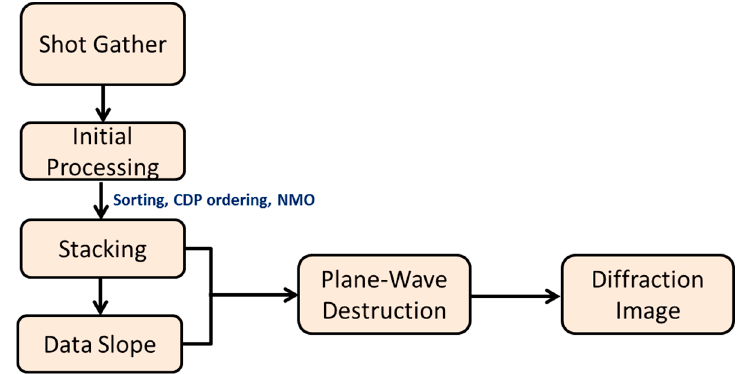
Figure 5. A diffraction separation workflow based on the slope estimation of the data before imaging [17].